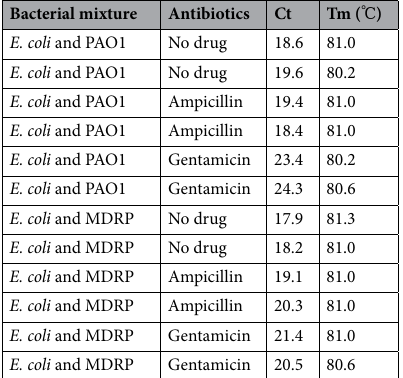
Table 1. Comparison of Ct values after antibiotic and propidium monoazide (PMA) treatment in bacterial mixtures. The effect of PMA was confirmed by comparing the Ct values obtained by real-time PCR using bacterial mixture. The bacerial genome of each sample was prepared to 3 ng and used for real-time PCR. The results show the proportion of viable bacteria in the 3 ng.